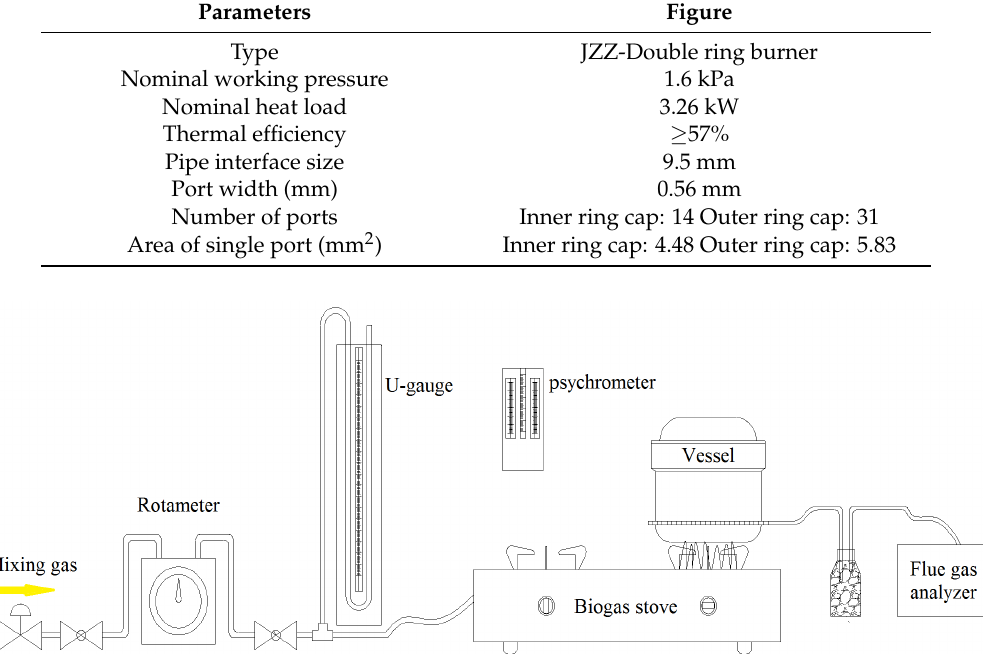
Figure 6. Schematic diagram of the test rigs and instrumentation.